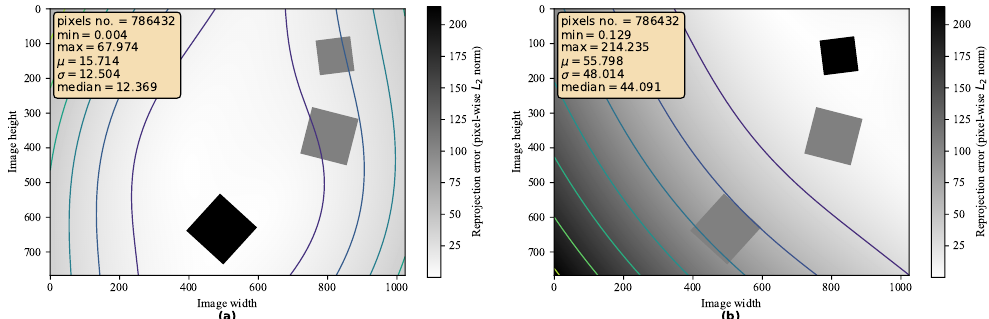
Figure 5. Distribution of pixel-wise reprojection error. The heat map together with corresponding contours demonstrate the varying distance between the ground truth and rectified pixel position after removing the perspective distortion. The bold square represents the reference marker. We show the result of ( a ) the “best” marker and ( b ) the “worst” marker. This test scenario includes all similarity transformations as well as noise in point